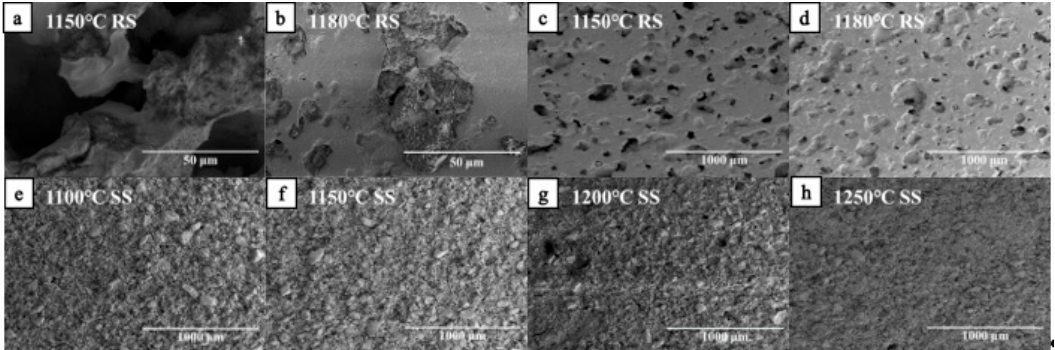
Figure 6. Microstructure diagram. ( a ) RS sintered at 1150 °C, 50 μ m; ( b ) RS sintered at 1180 °C, 50 μ m; ( c ) RS sintered at 1150 °C, 1000 μ m; ( d ) RS sintered at 1180 °C, 1000 μ m; ( e ) SS sintered at 1100 °C, 1000 μ m; ( f ) SS sintered at 1150 °C, 1000 μ m; ( g ) SS sintered at 1200 °C, 1000 μ m; ( h ) SS sintered at 1250 °C, 1000 μ m.